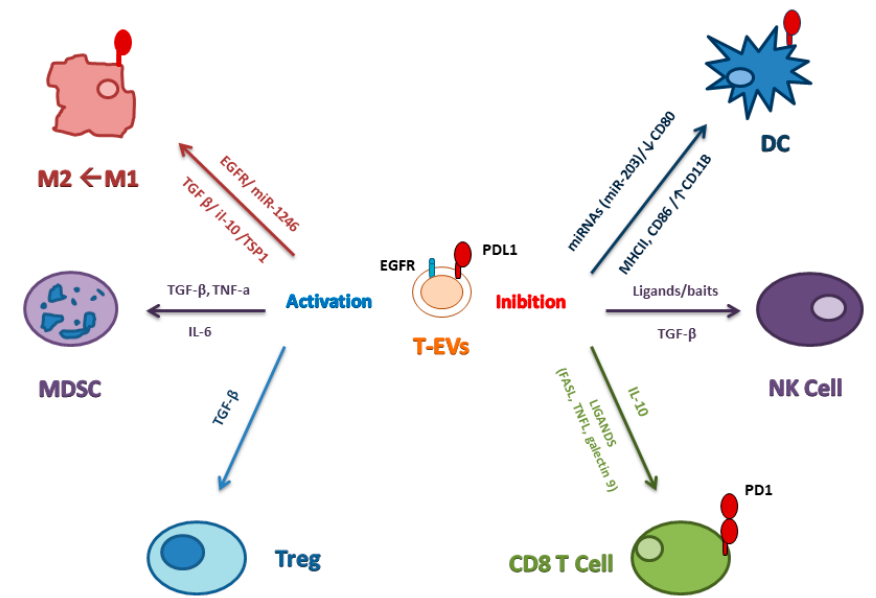
Figure 3. Immunity and extracellular vesicles in cancer. Schematic view of how T-sEVs repress the function of NK, T, and dendritic cells (DC) and activate the populations of myeloid-derived suppressive cells (MDSCs), regulatory T cells (Treg) while skewing macrophage function toward the M2 phenotype. PD-L1 packaged in T-sEVs is transferred to dendritic cells or macrophages which then block T cell function.